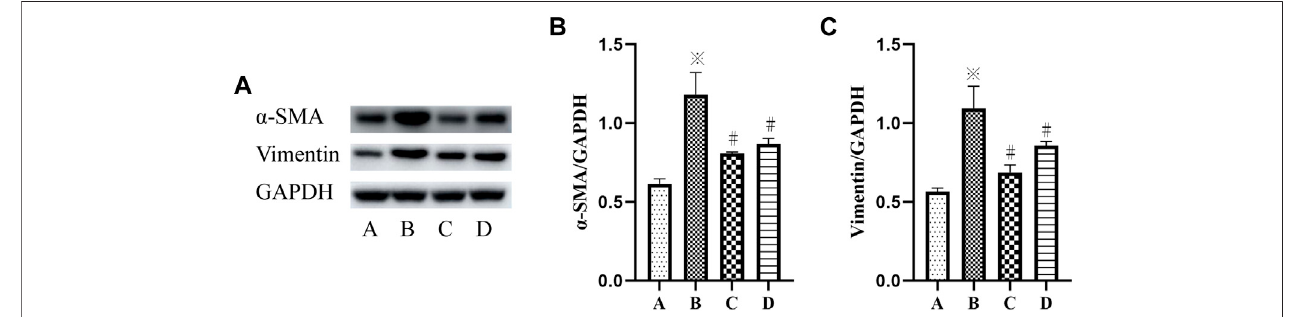
FIGURE 4 | (A – C) : α -SMA and vimentin levels in HELFs were detected using Western blotting. Cells were which were stimulated with VCR (1.4 μ g/ml) for 24 h in presenceofSB203580andPD98059.Datawerepresentedasmean±SEMfromthreeindependentexperiments.* p < 0.05 vs .thecontrolgroup;# p < 0.05 vs .theVCR